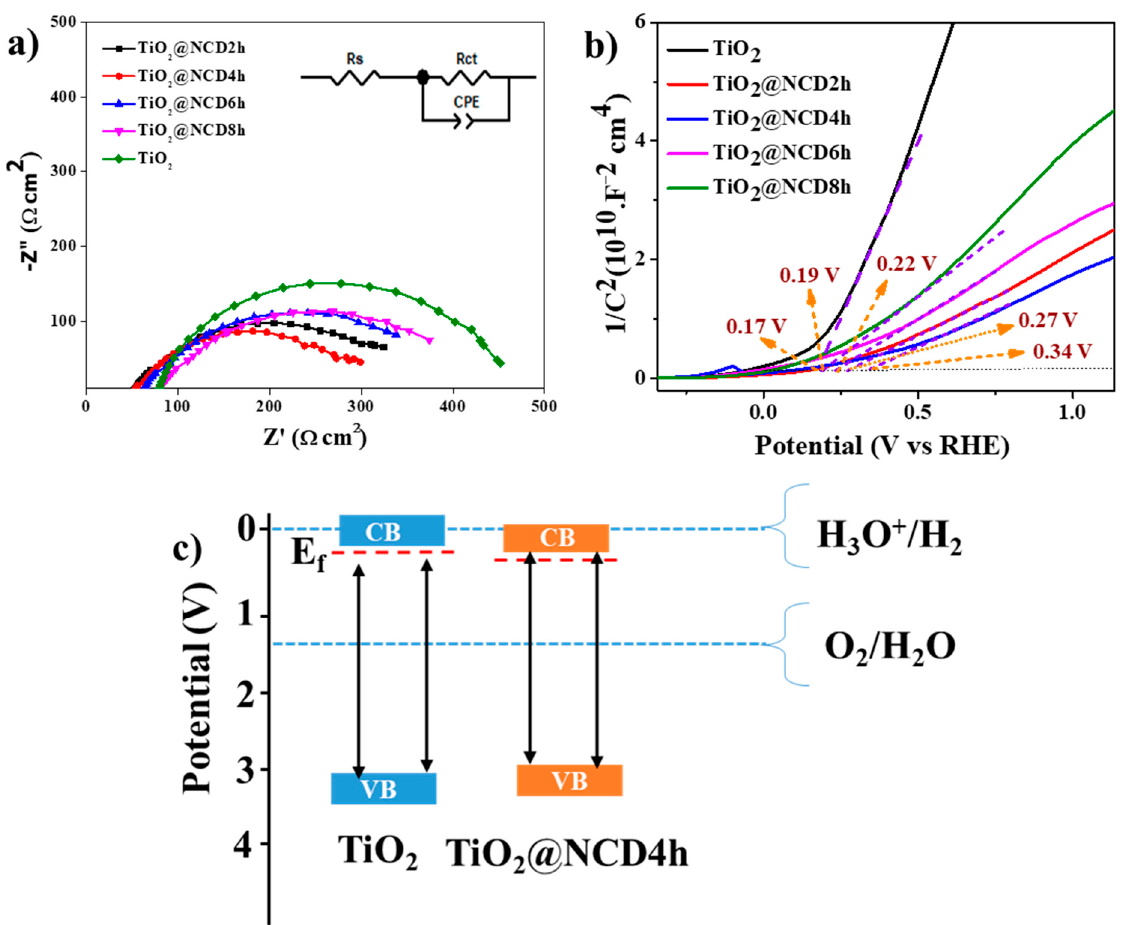
Figure 9. ( a ) EIS spectra; ( b ) 0 Mott–Schottky plots of TiO 2 , TiO 2 @NCD2h, TiO 2 @NCD4h, TiO 2 @NCD6h, and TiO 2 @NCD8h. ( c ) Schematic energy levels of TiO 2 , TiO 2 @NCD4h. TiO 2 @NCD6h, and TiO 2 @NCD8h. ( c ) Schematic energy levels of TiO 2 , TiO 2